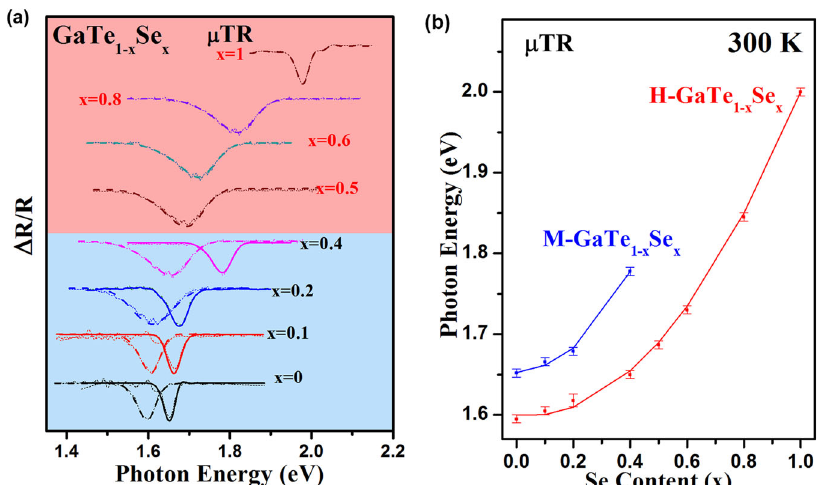
Fig. 4 The μ TR result of the band-edge transitions in M- and H-GaTe 1-x Se x . a The μ TR spectra of multilayered M-GaTe 1 − x Se x (0 ≤ x ≤ 0.4) and H-GaTe 1 − x Se x (0 ≤ x ≤ 1) at 300 K. The thin dashed lines are the experimental curves and the thick dashed lines and thick solid lines are respectively the fi tted curves of H-GaTe 1 − x Se x (0 ≤ x ≤ 1) and M-GaTe 1 − x Se x (0 ≤ x ≤ 0.4) using the derived Lorentzian line-shape function. b Band-edge transition energies of multilayered M-GaTe 1 − x Se x (0 ≤ x ≤ 0.4) and H-GaTe 1 − x Se x (0 ≤ x ≤ 1) as a function of selenium composition obtained from the μ TR measurement in ( a